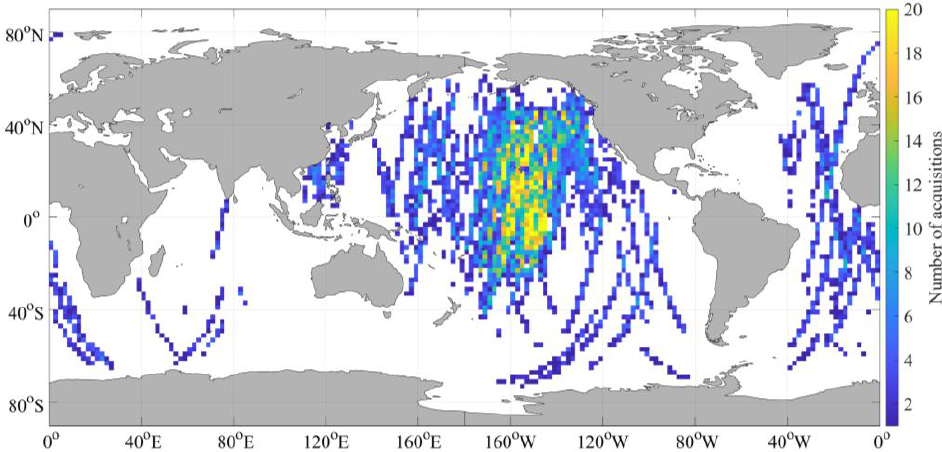
Figure 1. Map of the Gaofen-3 wave mode acquisitions for the year of 2016 to 2020 in data density for 2° × 2° bins.